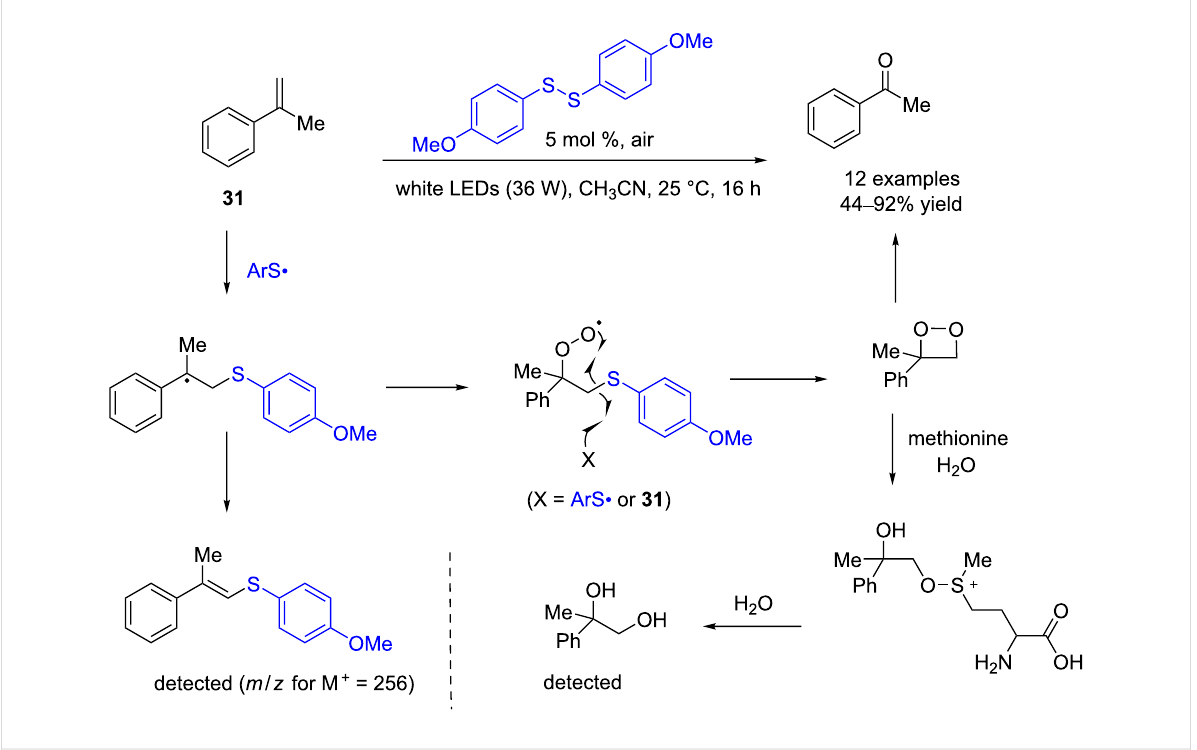
Scheme 9: Disulfide-catalyzed aerobic photooxidative cleavage of olefins.